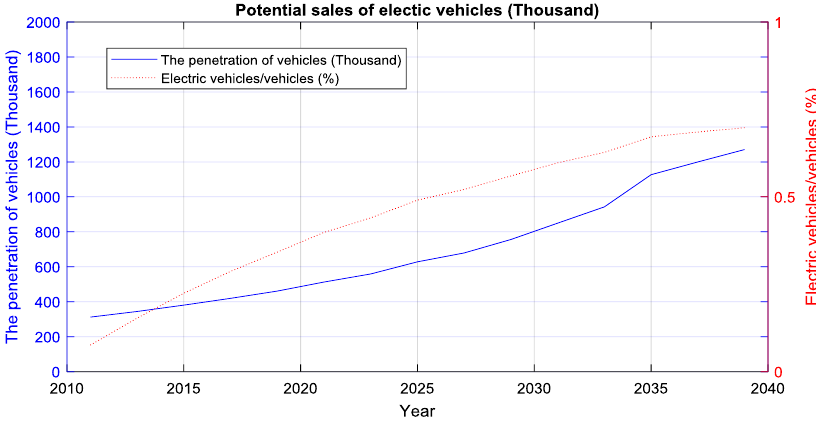
Figure 6. Potential sales of electric vehicles.